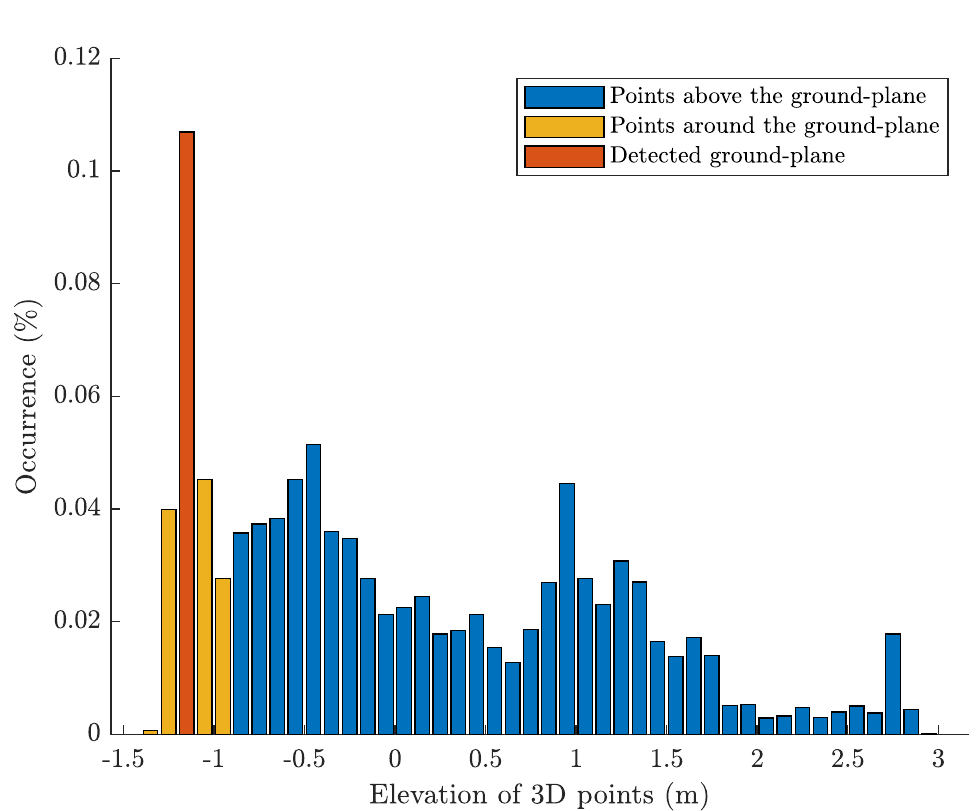
Figure 2. Histogram of vertex elevations in the acquired environmental mesh. The ground–plane is estimated as the middle–point of the most numerous bin (10 cm wide) among the first 10% of the mesh’s elevation